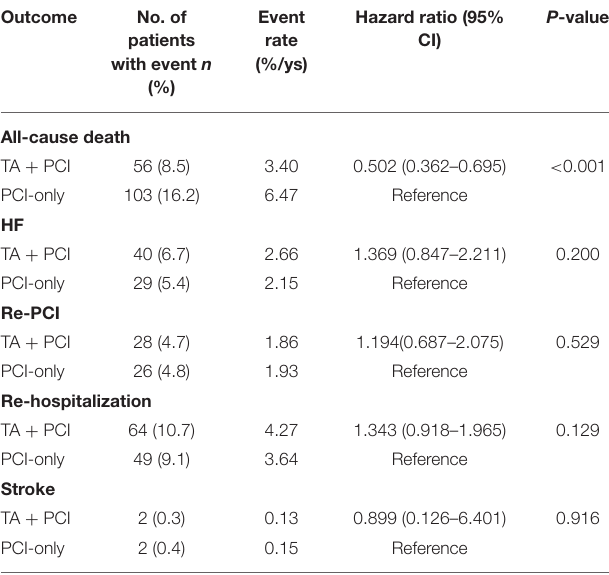
TABLE 3 | Primary and secondary end points in the all enrolled